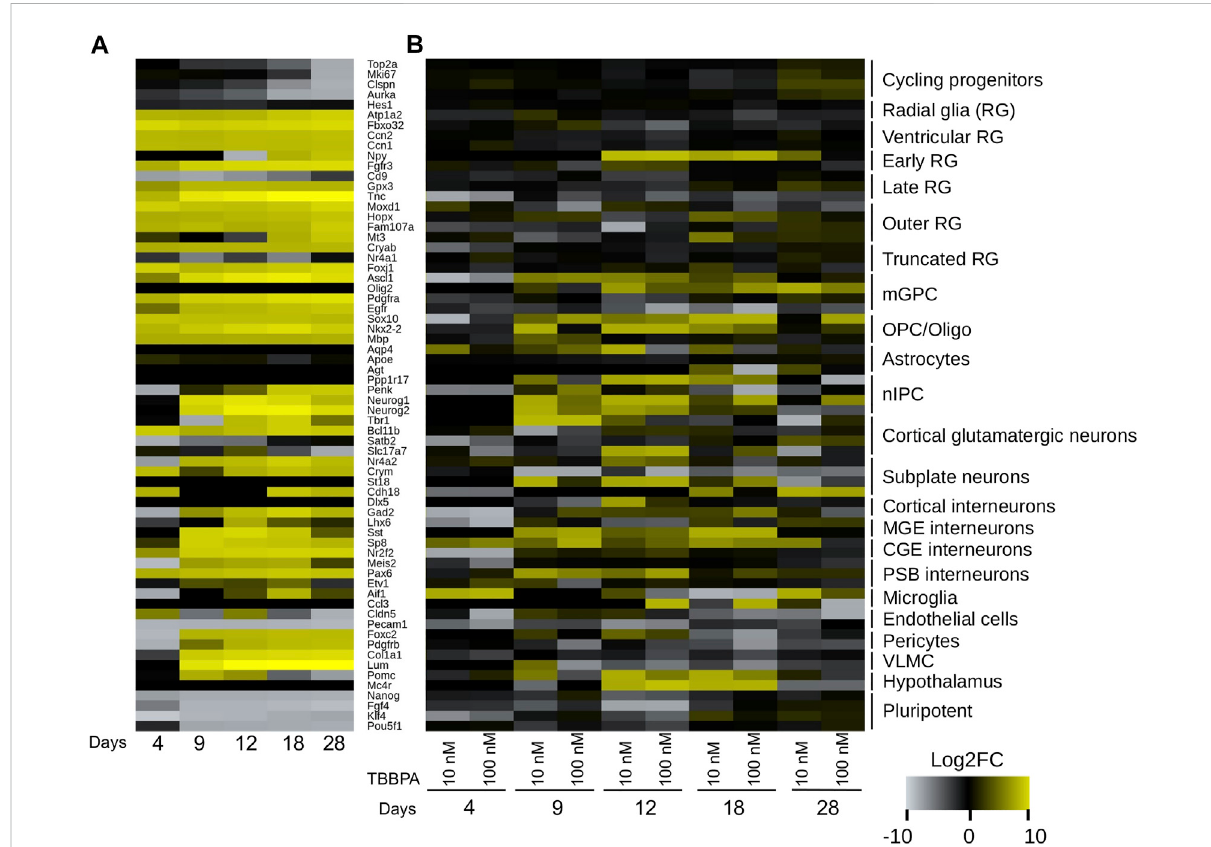
FIGURE 5 Time dependent evolution of differentiation markers. Heatmaps of expression changes (Log 2 scale). (A) Spontaneous differentiation without treatment (D0 vs. D4, D9, D12, D18 and D28). (B) After 10 nM or 100 nM TBBPA treatment. RG: radial glia. mGPC: multipotent glial progenitor cell. nIPC: neuronal intermediate progenitor cell. MGE: medial ganglionic eminence. CGE: caudal ganglionic eminence. PSB: pallial-subpallial boundary. VLMC: leptomeningeal cell. Markers are from (Trevino et al.,